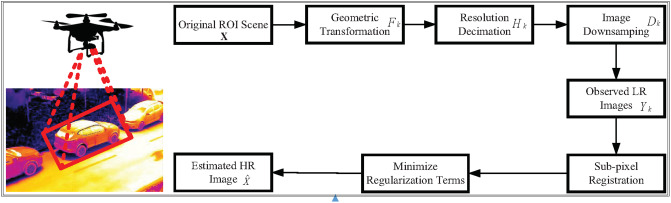
Super-resolution reconstruction workflow.